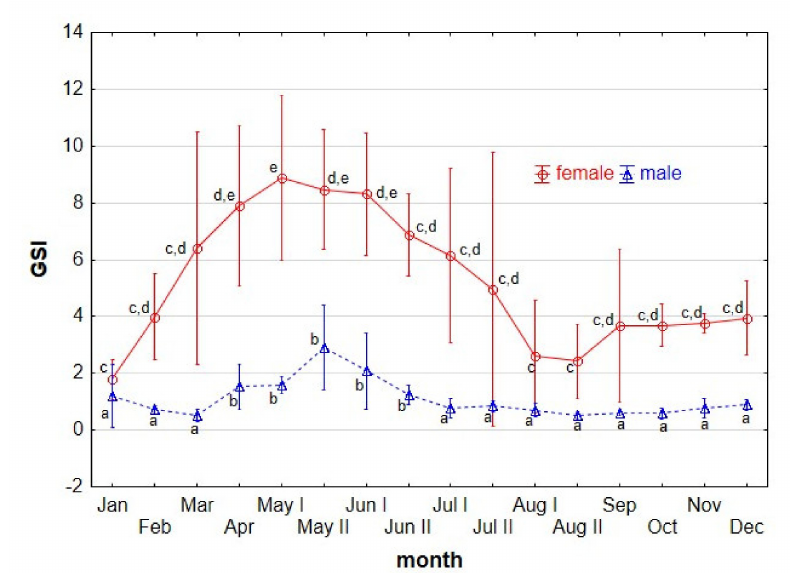
Figure 3. Monthly changes of gonadosomatic index (GSI) of stone moroko. ( Pseudorasbora parva ) fe- male and male inhabiting the Wardynka river, Poland. Values with different letters show significance differences ( p < 0.05; ANOVA